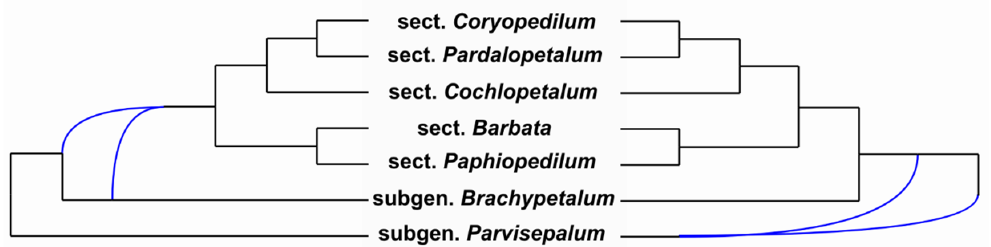
Figure 3. Two of the most probable Bayesian MCMC phylogenetic networks (log = − 13.19688, log = − 13.75276) using gene tree topologies (nuclear— ACO , DEF4 , PHYC , XDH , LFY , RAD51 , and plastid tree). The Blue line indicates possible scenarios of hybridization.